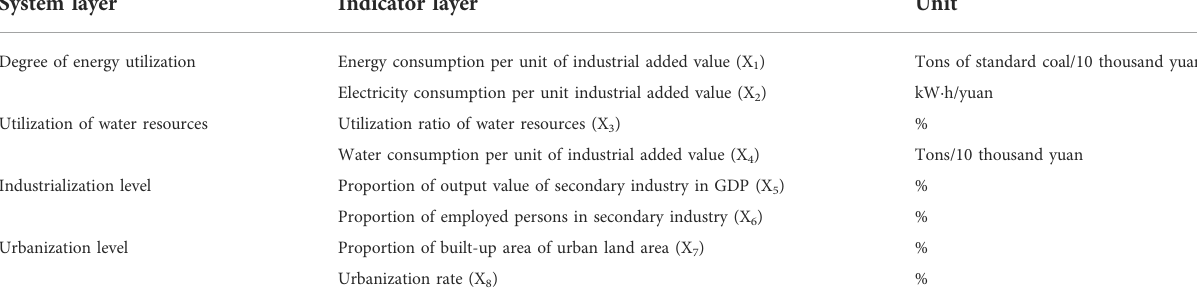
TABLE 3 Coupling driving factor index